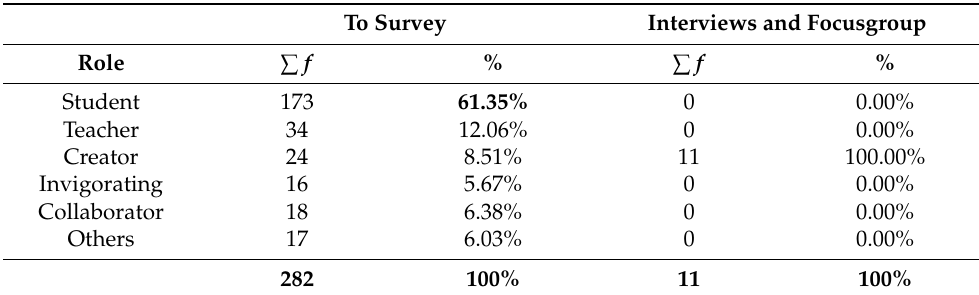
Table 5. Roles played in sMOOC/tMOOC. To Survey Interviews and